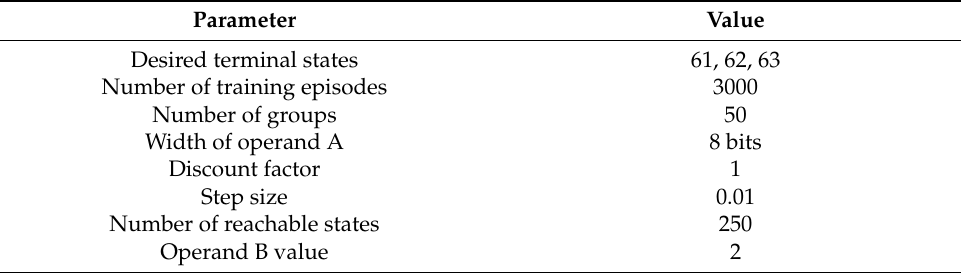
Table 5. Values of training parameters for the results in Table